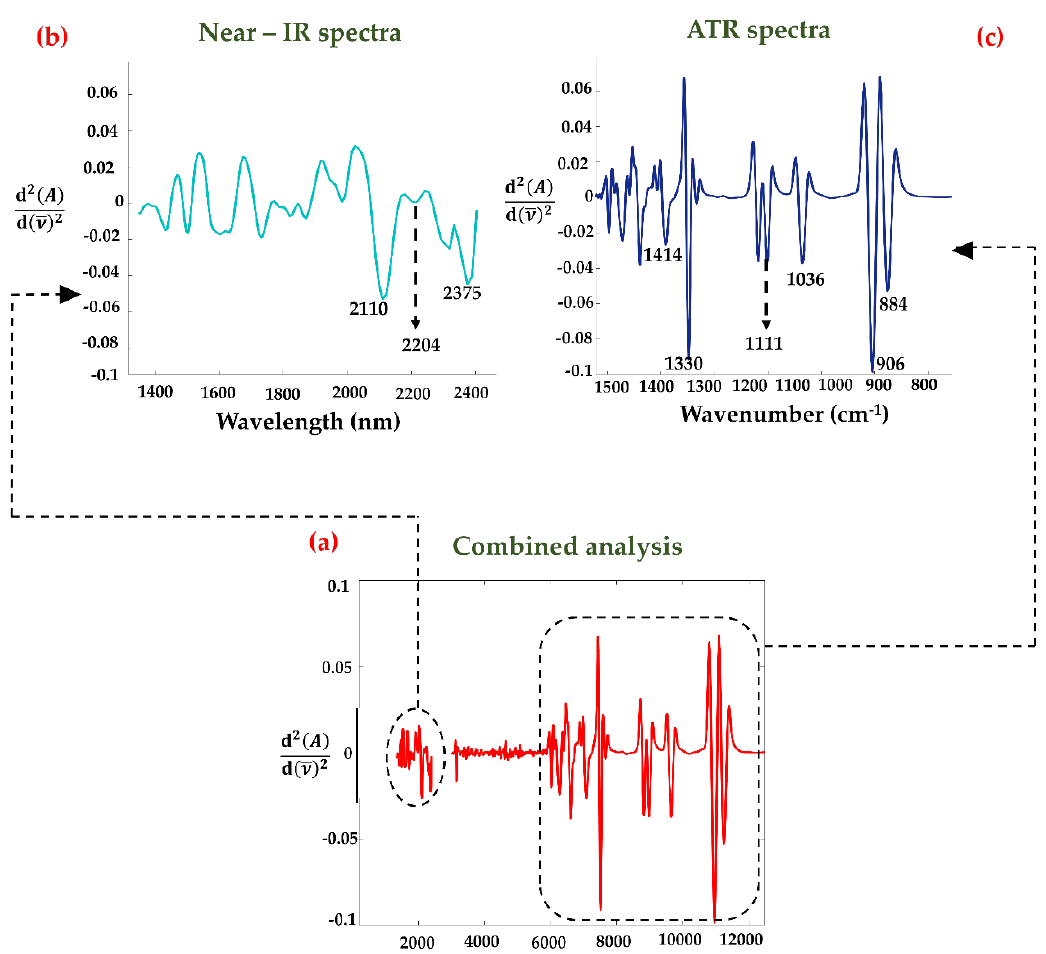
Figure 2 . ( a ) Second derivatized spectra of fused ATR – NIR datasets of dried glycine deposits in 12500 – 1350 nm region. Magnified view of ( b ) NIR region (2500 – 1350 nm) and ( c ) mid-IR region (1600 – 800 cm −1 ). Important bands in the spectra are